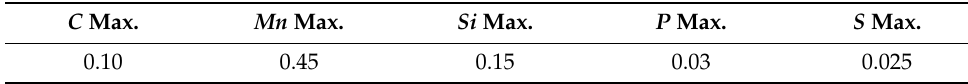
Table 1. Chemical impurities in investigated steel in %. C Max.